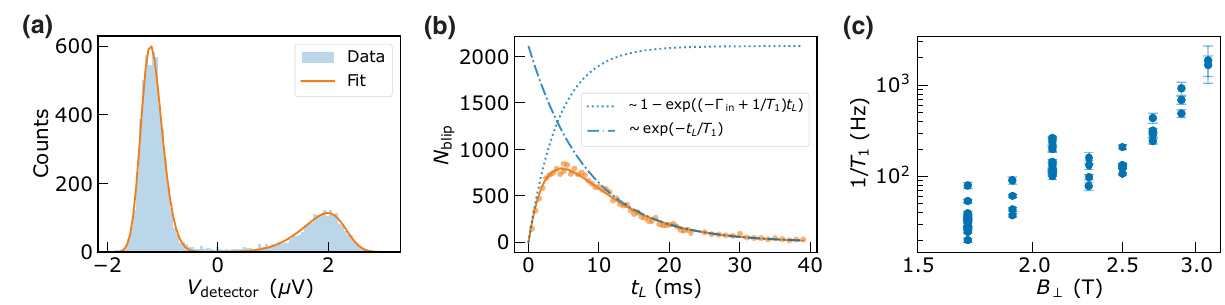
FIG. 4. (a) Histogram of maximum detector voltage values during the read phase. The histogram is fitted with two skewed Gaussians with γ GS = − 1.7, μ GS = − 1.4 μ V, σ GS = − 0.27 μ V and γ ES = 2.76, μ ES = 2.3 μ V, σ ES = − 0.6 μ V. (b) Number of blips observed during read phase as a function of loading time. The relaxation time is extracted from the exponential decay. (c) Magnetic field dependence of the relaxation rate 1 / T 1 . Data points for one magnetic field correspond to statistically independent